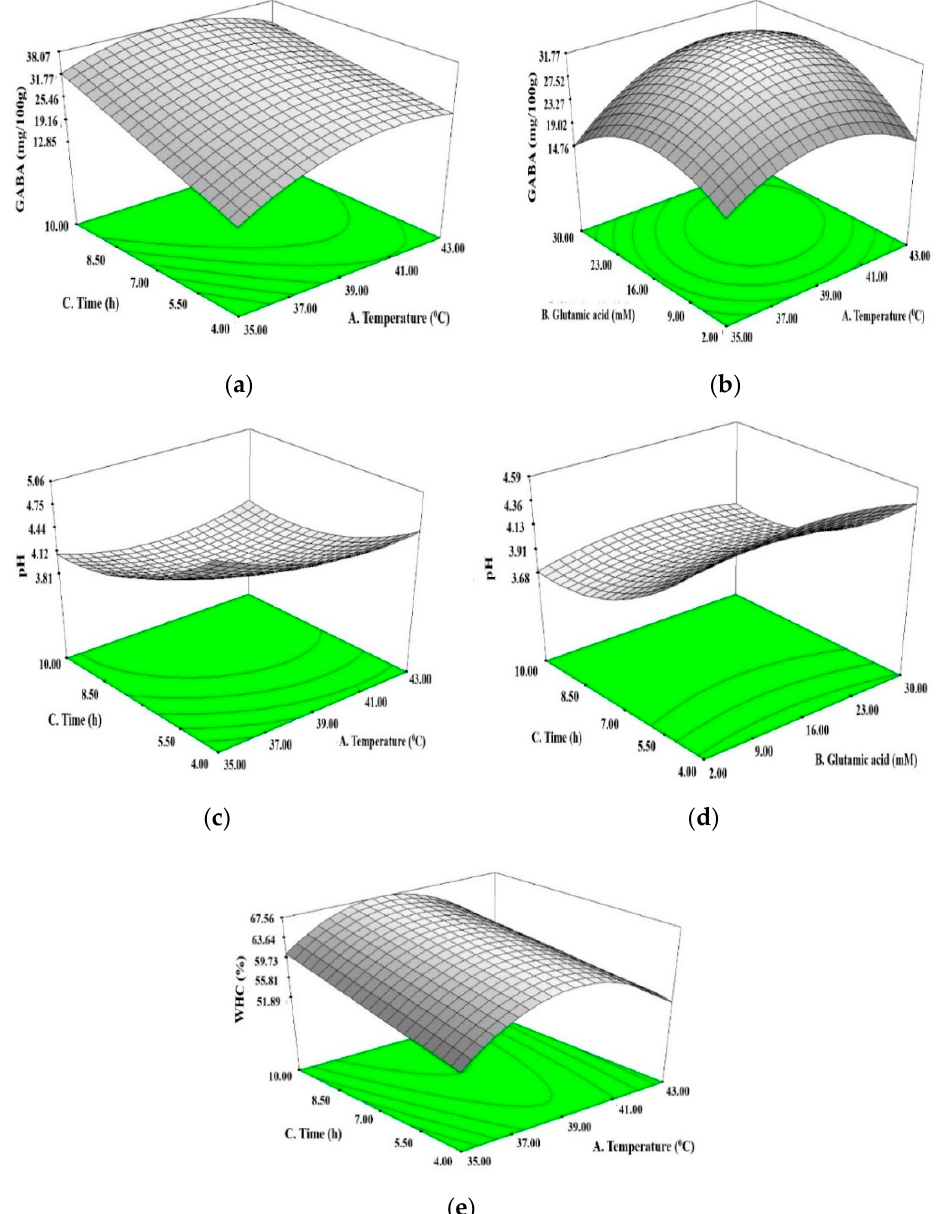
Figure 2. Three-dimensional response surface plots showing significant interaction between different factor combinations during fermentation; ( a ) Effect of temperature and glutamate on GABA, ( b ) Effect of temperature and time on GABA, ( c ) Effect of temperature and time on pH, ( d ) Effect of glutamate and time on pH; and ( e ) Effect of temperature and time on water-holding capacity.